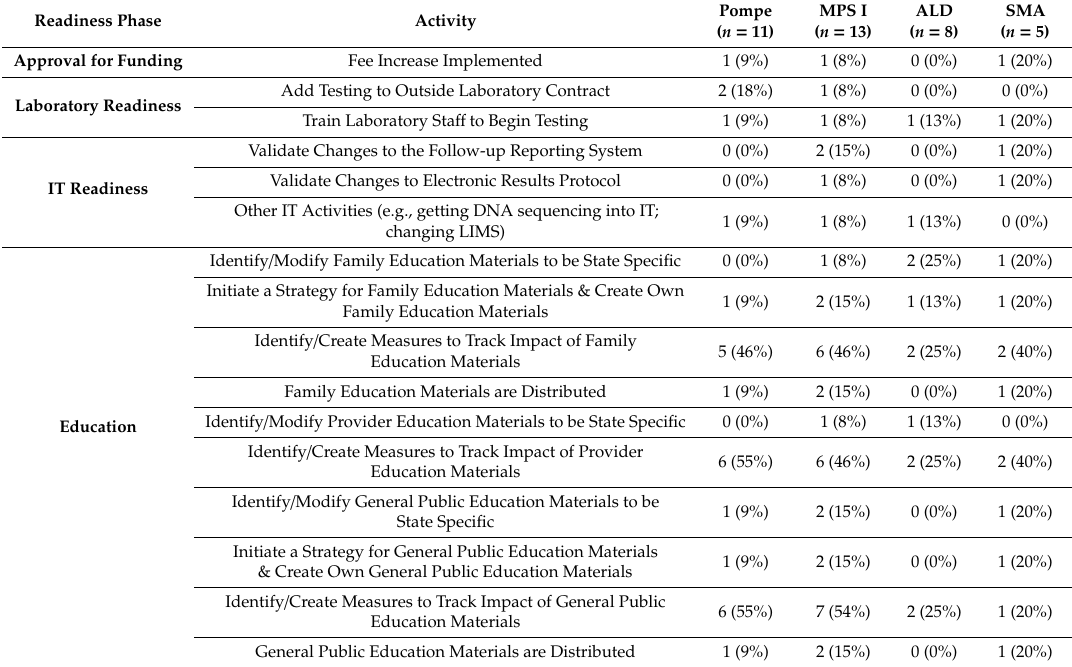
Table 2. Readiness Activities Completed Post-Implementation * of Statewide Newborn Screening that Occurred for at least Two New Disorders; Collected from the New Disorders Readiness Tool, as of August